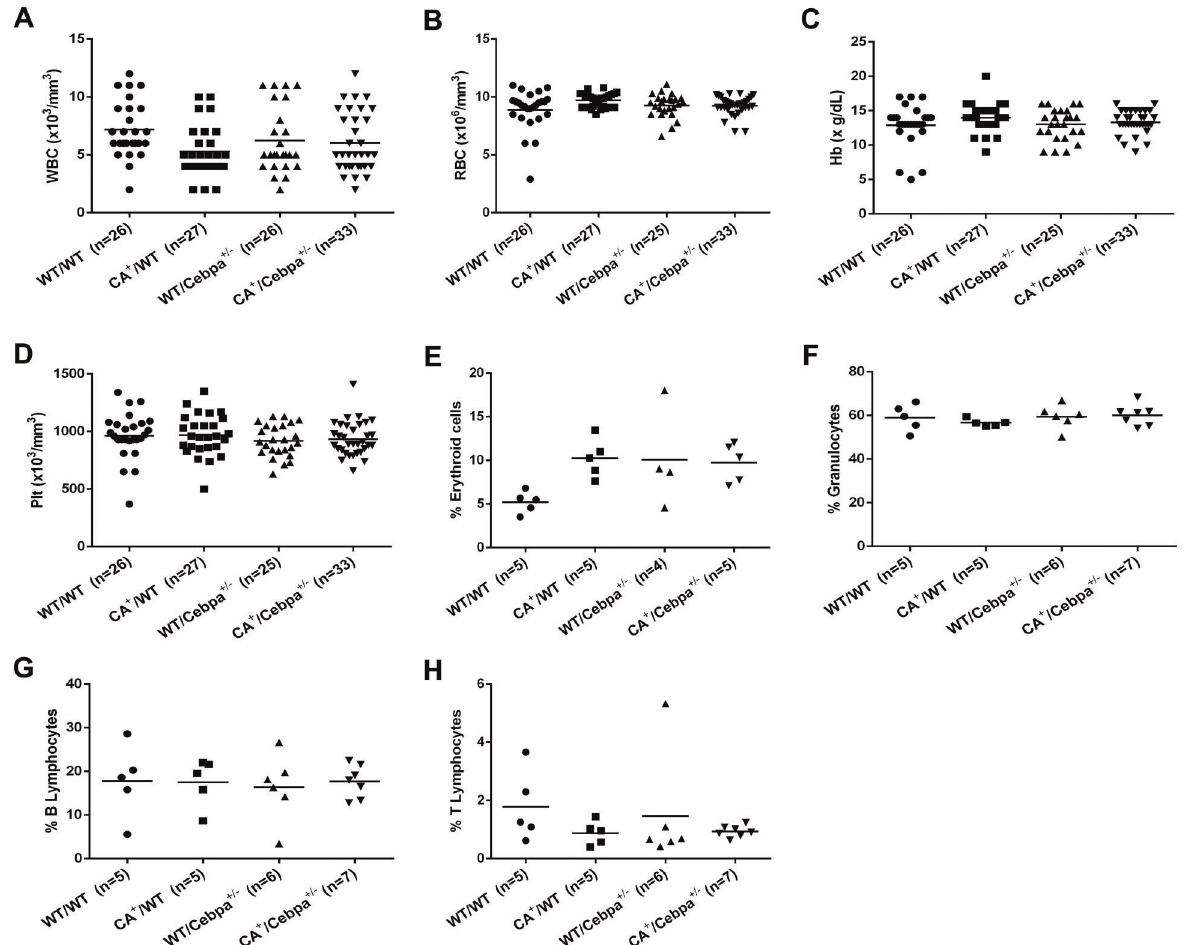
Figure 1. Hematological parameters and immunophenotypic characterization of bone marrow cells of adult mice (9 to 15 months). A , WBC: leukocyte counts. B , RBC: red blood cell counts. C , Hb: hemoglobin concentrations. D , Plt: platelet counts. E , Percentage of erythroid cells. F , Percentage of granulocytes. G , Percentage of B lymphocytes. H , Percentage of T lymphocytes. Each dot represents an individual mouse and lines indicate the median. WT/WT : wild-type (control); CA + / WT : CALM/AF10 ; WT/Cebpa + / – : Cebpa + / – ; CA + / Cebpa + / – : double-mutant mice. No signi fi cant difference was found between groups. Statistical analysis was performed with the Kruskal-Wallis test followed by Dunn ’ s multiple comparison